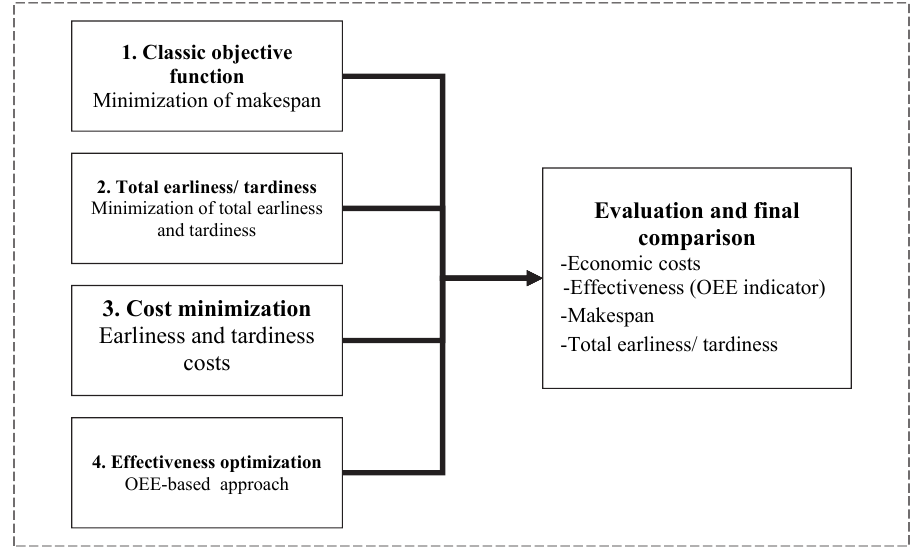
Fig. 2. General schematic of the methodology.